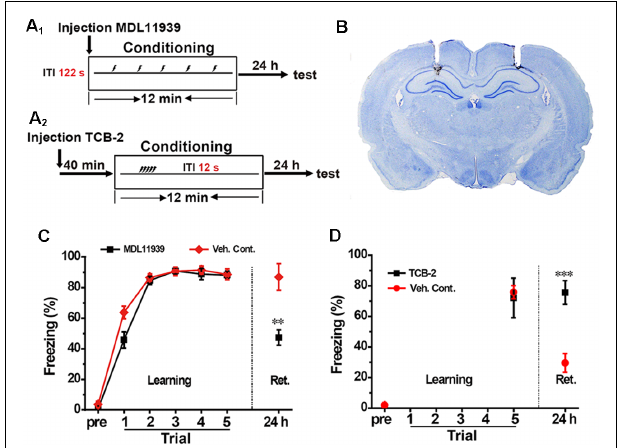
FIGURE 2 | Inhibition of hippocampal 5-HT2A receptors blocked the spacing effect, while activation of hippocampal 5-HT2A receptors promoted the spacing effect. (A 1 ,A 2 ) Diagram for experimental procedures. (B) Representative Nissl staining confirming the implantation sites of the guide cannulas. (C) Hippocampal administration of 5-HT2A receptor antagonist MDL11939 blocked the enhanced fear memory in the spaced training ( n = 8). (D) Hippocampal administration of 5-HT2A receptor agonist TCB-2 enhanced fear memory in the massed training ( n = 9). All results were presented as mean ± SEM, ∗∗ p < 0.01, ∗∗∗ p < 0.001.